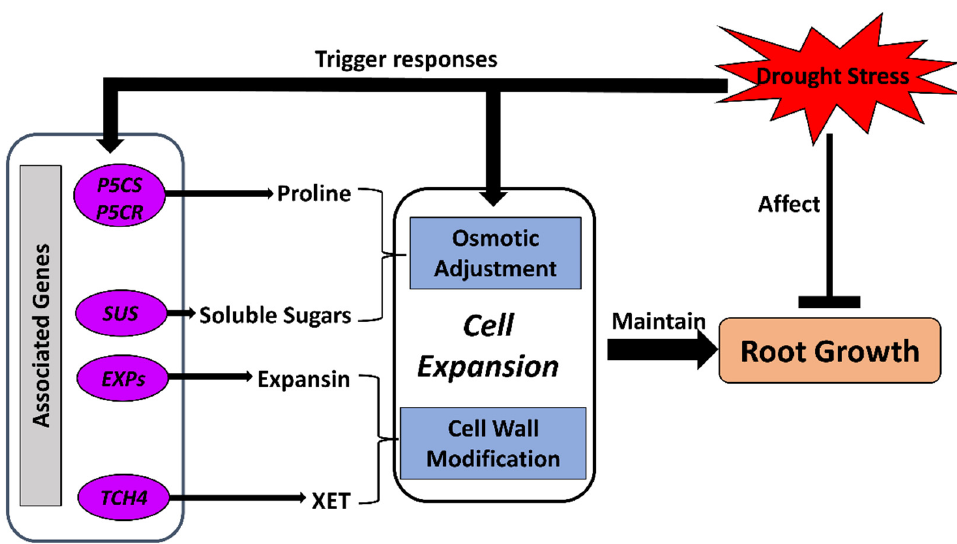
Figure 3. Osmotic adjustment and cell-wall modification processes for cell expansion in response to drought stress in crop roots. Drought stress limits root growth while triggering the regulatory mechanisms of an osmoprotectant. Regulatory genes are activated to accumulate osmolytes and modify cell-wall components for extensibility. The regulated cellular osmotic status and cell walls assist the expansion of root cells and, therefore, maintain growth of crop roots under drought stress. EXPs , EXPANSIN genes; P5CR , pyrroline-5-carboxylate reductase gene; P5CS , pyrroline-5-carboxylate synthetase gene; SUS , sucrose synthase gene; TCH4 , xyloglucan:xyloglucosyl transferase gene.